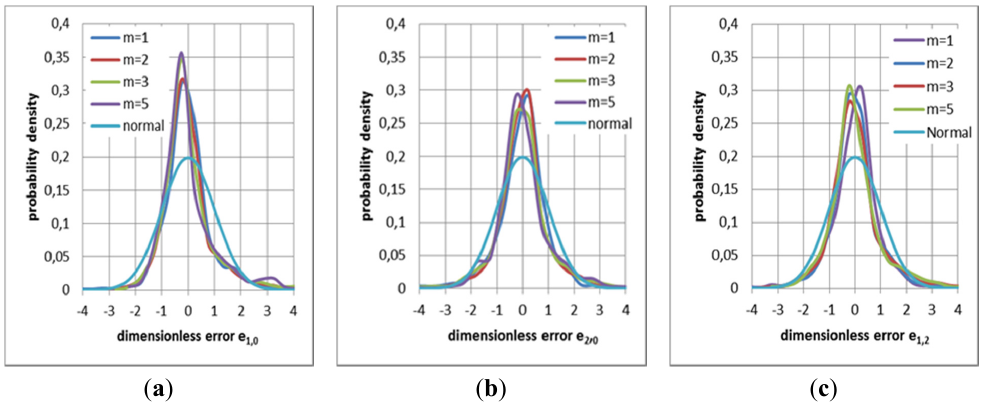
Figure 5. Probability densities of errors for cases of model combinations. ( a ) pdf of error e 1,0 ; ( b ) pdf of error e 2.3,0 ; ( c ) pdf of error e 1,2.3 .